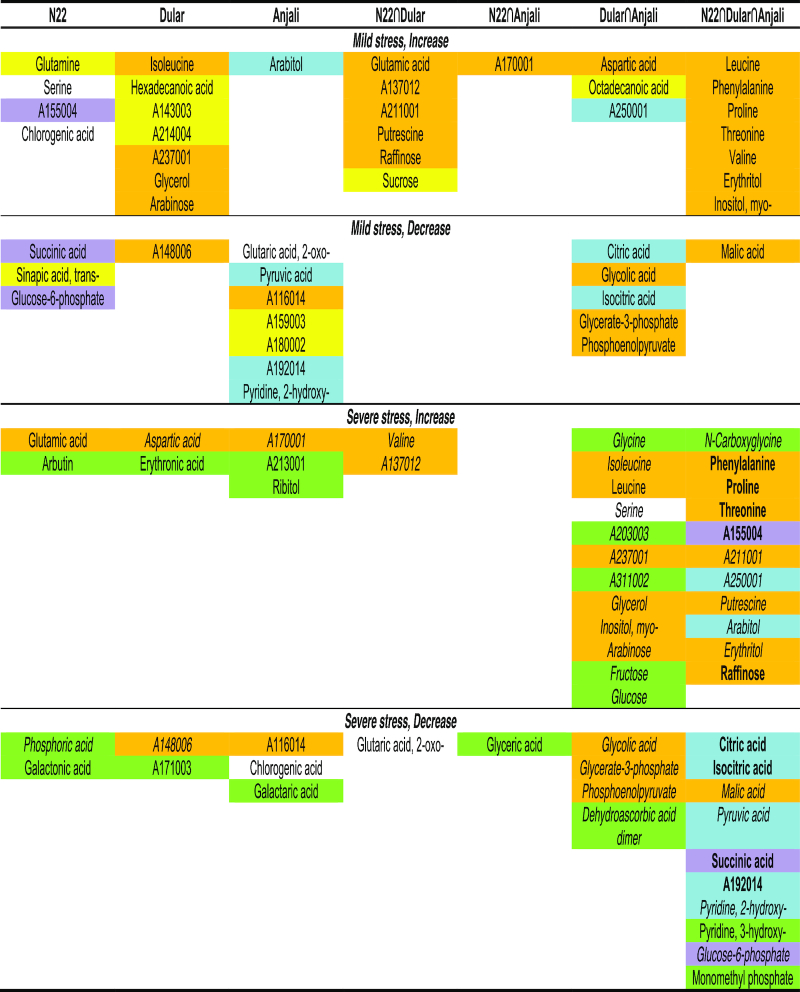
Common and cultivar-specific stress-responsive metabolites in flag leaves during flowering. Metabolites correspond to the numbers in the Venn diagrams in Fig. 6A−D. Comparisons between responses to early, mild and late, severe stress are color-coded: orange: common response irrespective of stress intensity; yellow: mild stress−specific; green: severe stress−specific; purple: rapid response in tolerant cultivar N22, delayed response in the more susceptible cultivars; blue: rapid response in susceptible cultivars, delayed response in tolerant cultivar. Severe stress responses in flag leaves common between the flowering (Fig. 7) and early grain-filling stages (Fig. 8) are differentiated by font style: boldface: common responses among all cultivars between the 2 stages; italics: cultivar-specific metabolites with similar responses in the same cultivars across the 2 stages. Quinic acid, 5-caffeoyl-, trans- is listed as chlorogenic acid; 4-hydroxyphenyl-β-glucopyranoside as arbutin; glyceric acid−3-phosphate as glycerate-3-phosphate; phosphoenolpyruvic acid as phosphoenolpyruvate; phosphoric acid monomethyl ester as monomethyl phosphate.